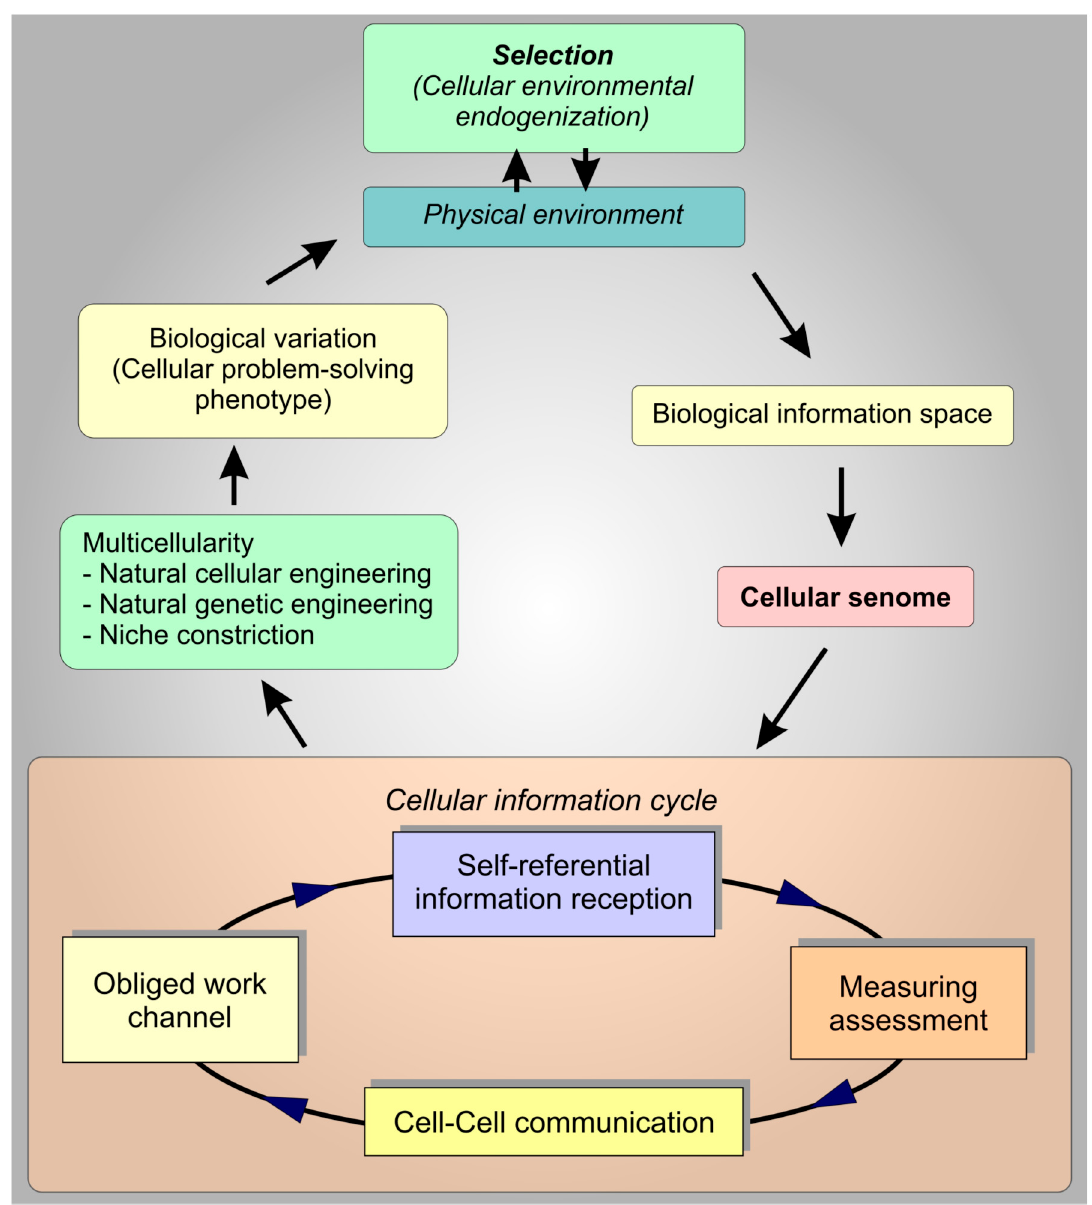
Figure 2. An informational interactome governs natural cellular engineering. In all circumstances, any phenotypic shift that natural cellular engineering produces is directed toward the continuous internalization of the external environment to maintain the homeorhetic equipoise of all constituent cells of the macroorganism. In this manner, biological variation represents the deliberate adjustment of cellular participants to a stream of environmental cues in the consistent attempt to maintain organismal-environ- mental complementarity. Importantly, collective cellular drive is always epicentered at the level of each engineering participant cell, no matter the size of the cellular collective. This is not any emergent property. Instead, it is the very basic tenet of cellular life. The cellular imperative is the protection of self-identity [7]. Collective action is its advantaged means. Thus, there is no explicit design or designer. It is always a process of self-reinforc- ing and iterative progression to sustain individual participants in a collective biological